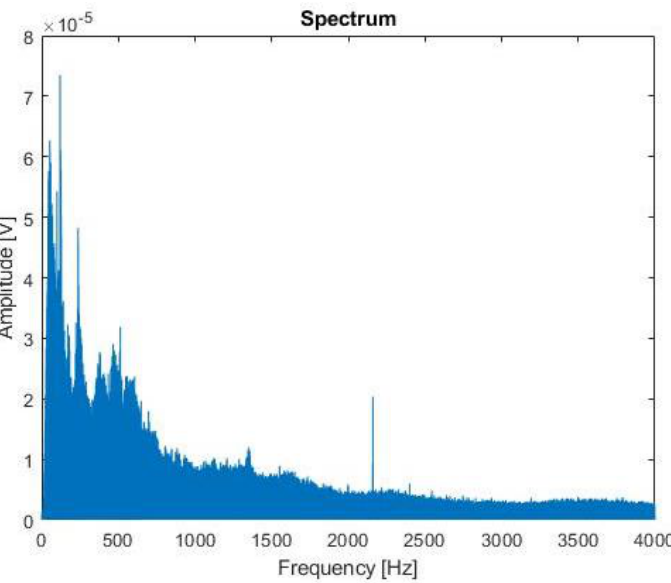
Figure 5. Recording sound from the room.